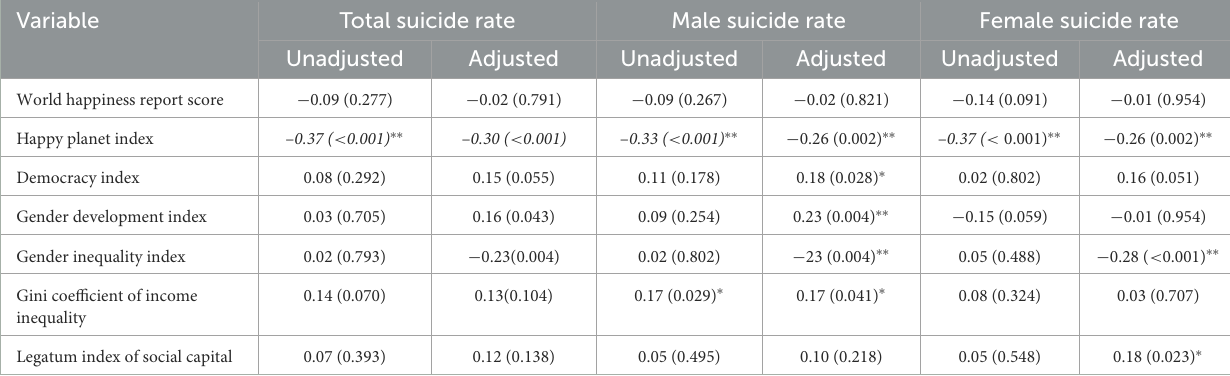
TABLE 2 Adjusted and unadjusted bivariate correlations between social and economic indices and suicide